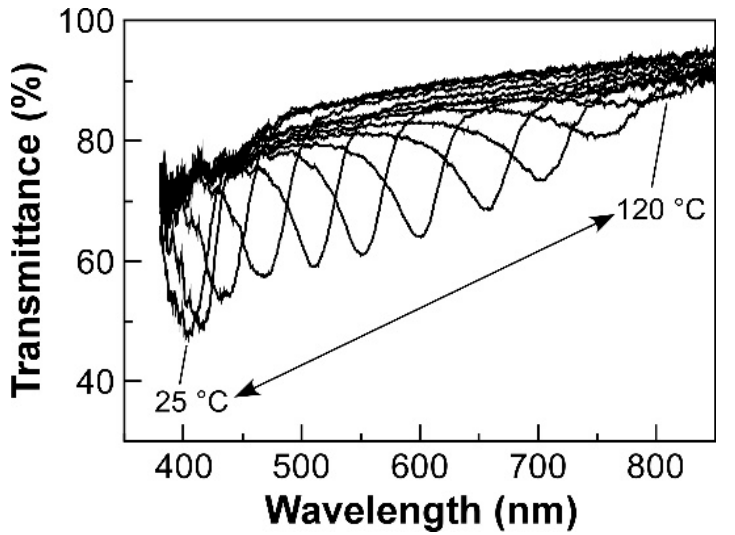
Figure 3. Changes in the transmission spectrum of the CLC cell of HPC-PeEt upon heating process from 25 °C to 120 °C.